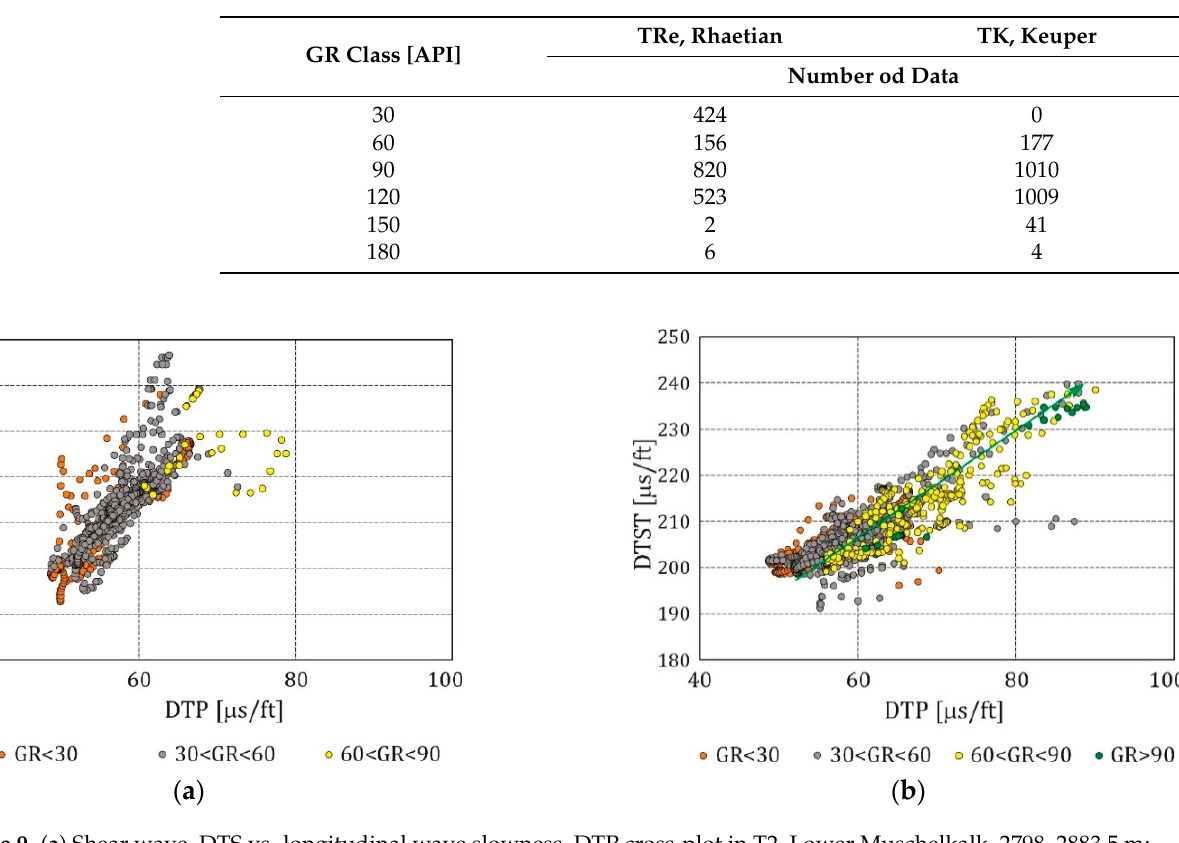
Figure 9. ( a ) Shear wave, DTS vs. longitudinal wave slowness, DTP cross ‐ plot in T2, Lower Muschelkalk, 2798 – 2883.5 m; GT ‐ 1 borehole; low GR anomalies in carbonate rocks. ( b ) Stoneley wave (DTST) vs. longitudinal wave slowness, DTP cross ‐ plot in T2, Muschelkalk and Tp3, Bunter Sandstone, 2771 – 2912 m; GT ‐ 1 borehole; increase of shaliness (green line) caused increase of DTST. Table 8. Numerical data for histograms in Figure 8c.